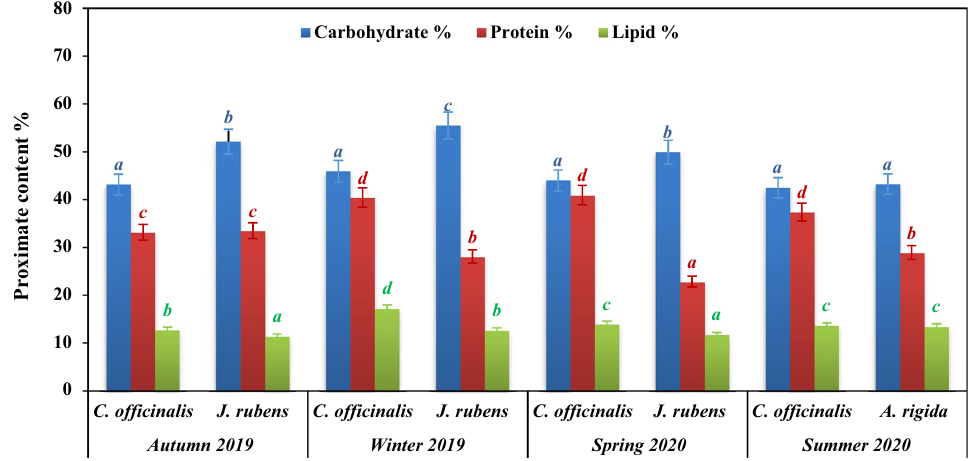
Fig. 11 Proximate contents (%) of seasonally collected calcified species